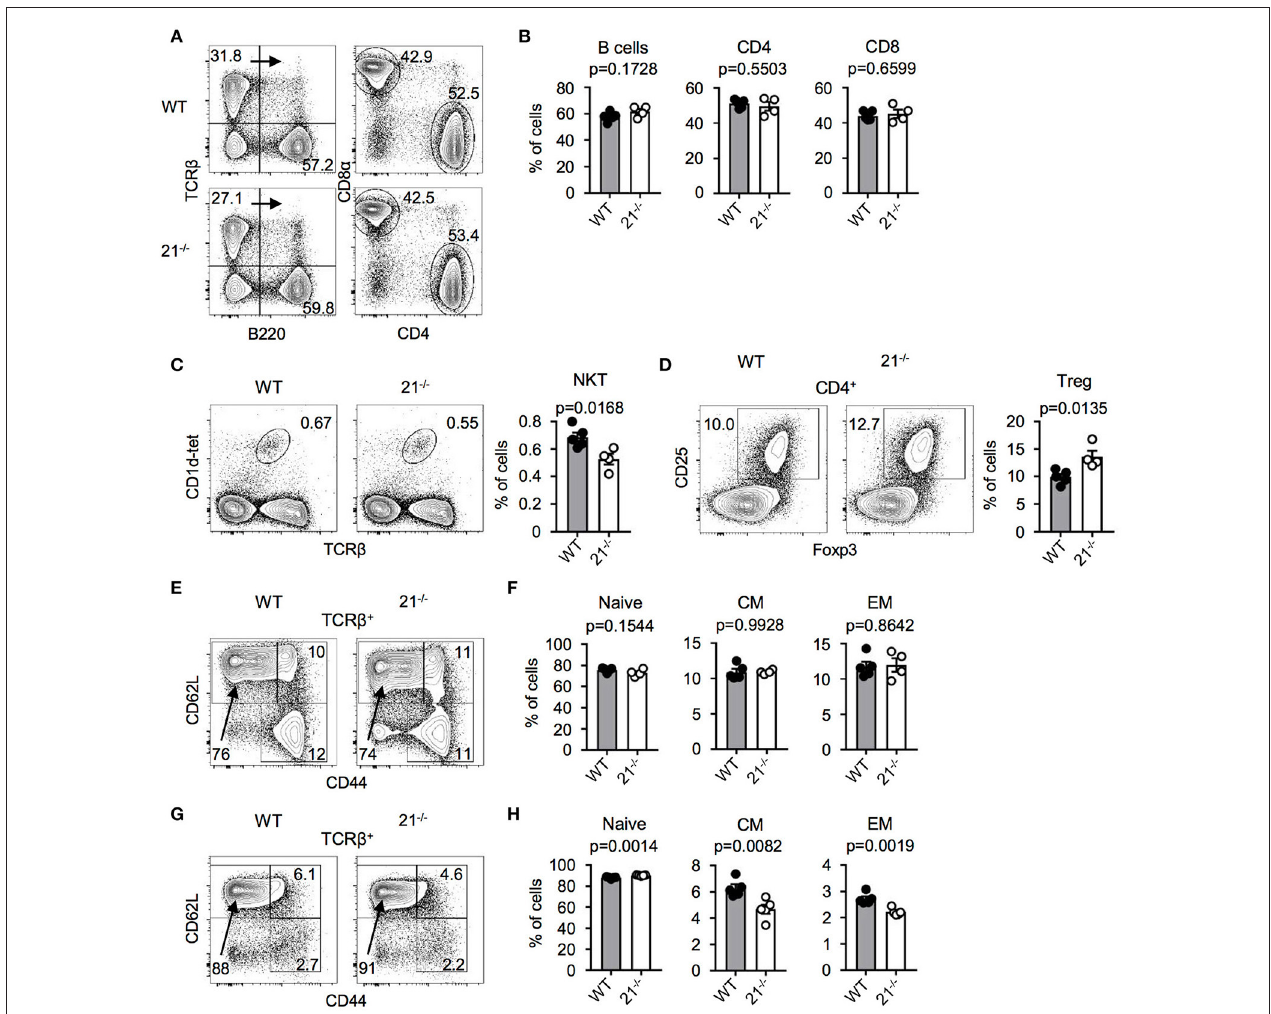
FIGURE 4 | Physiological peripheral lymphoid cell frequencies in miR-21 − / − mice. (A) Representative flow cytometric analysis and gating strategy of spleen from WT and miR-21 − / − mice stained with antibodies against B220, TCR β , CD4, and CD8 α . Numbers in quadrants or adjacent to gates represent frequencies. (B) Statistical analysis of flow cytometric results shown in (A) , n = 4-5. (C) Representative flow cytometric and statistical analysis of spleen from WT and miR-21 − / − mice stained with CD1d-tet and antibody against TCR β . Numbers in right corners of plots represent frequency, n = 4-5. (D) Representative flow cytometric and statistical analysis of spleen from WT and miR-21 − / − mice stained with antibodies against CD4, CD25, and Foxp3. Numbers in left corners of plots represent frequency, n = 4-5. (E) Representative flow cytometric analysis of spleen from WT and miR-21 − / − mice stained with antibodies against TCR β , CD44, and CD62L to identify naïve (CD44 − CD62L + ), central memory (CD44 + CD62L + ) and effector memory (CD44 + CD62L − ) T-cell subsets. Numbers in or adjacent to gates represent frequency. (F) Statistical analysis of flow cytometric results shown in (E) , n = 4-5. (G) Representative flow cytometric analysis of LNs from WT and miR-21 − / − mice stained with antibodies against TCR β , CD44, and CD62L to identify naïve (CD44 − CD62L + ), central memory (CD44 + CD62L + ) and effector memory (CD44 + CD62L − ) T-cell subsets. Numbers in or adjacent to gates represent frequency. (H) Statistical analysis of flow cytometric results shown in (G) , n =